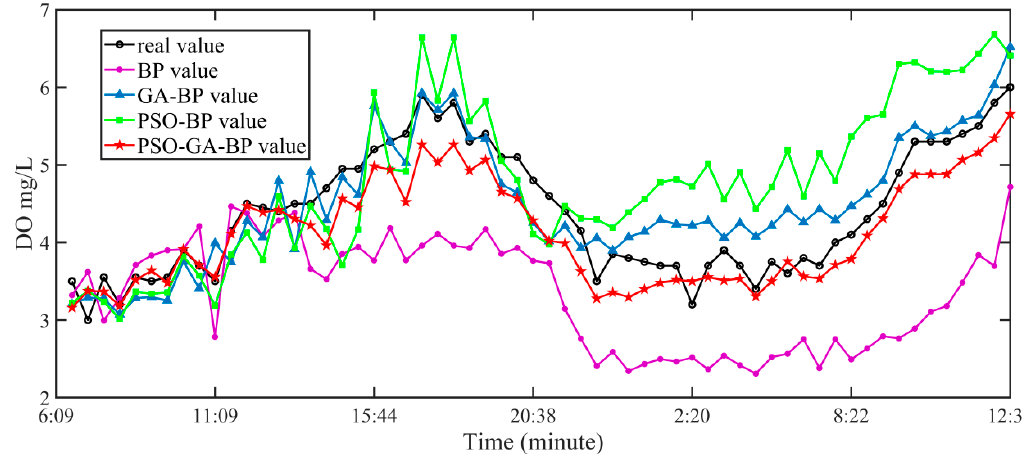
Figure 3. Comparison of predictions by the BPNN, PSO-BPNN, GA-BPNN, and PSO-GA-BPNN 279